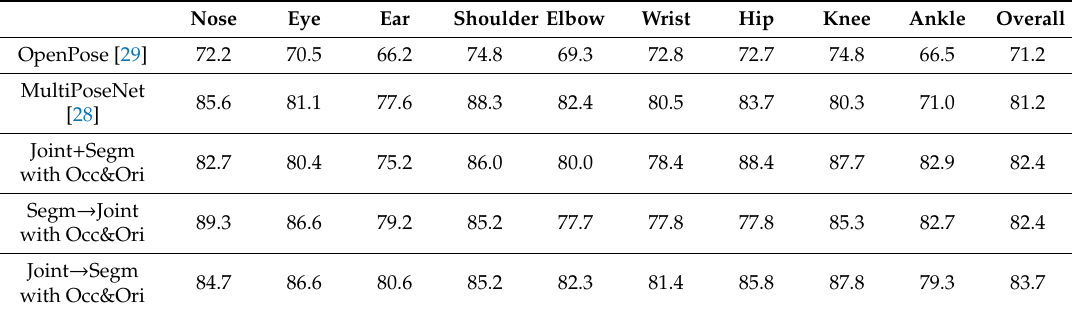
Table 6. Comparison between proposed models and other methods using Correct Detection Rate (CDR; %).